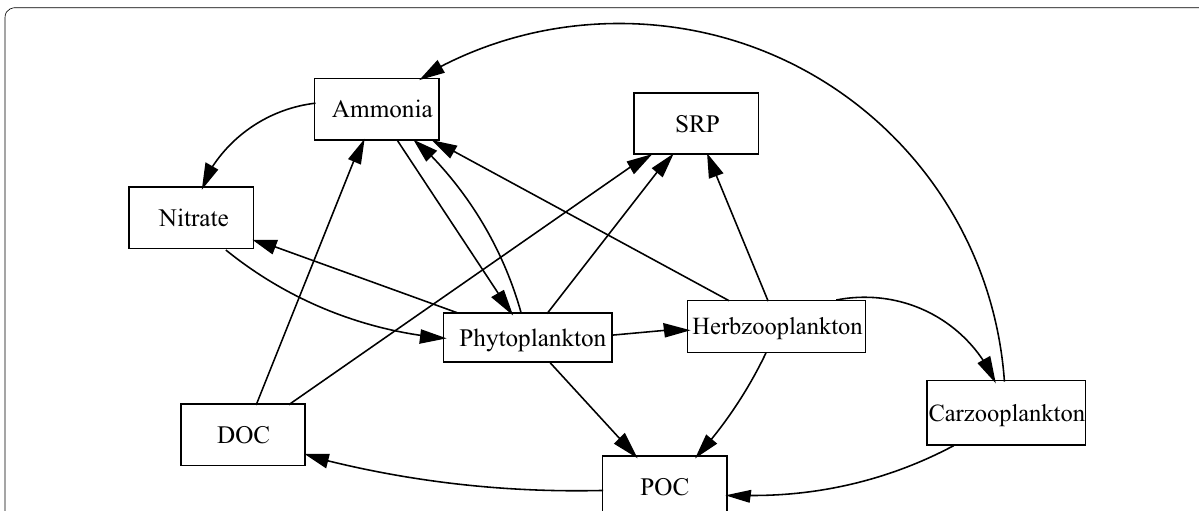
Fig. 3 General relationships diagram between stocks in the model